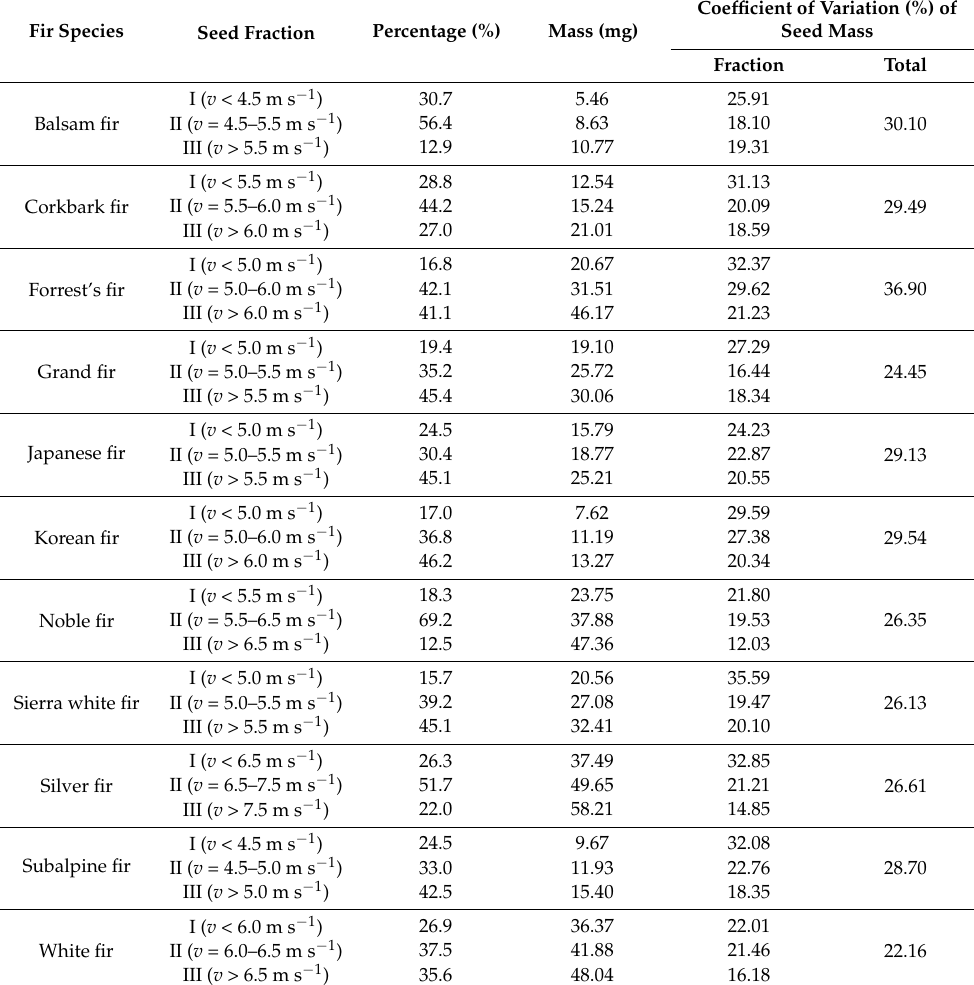
Table 5. Coefficient of variation of seed mass in three seed fractions separated based on terminal